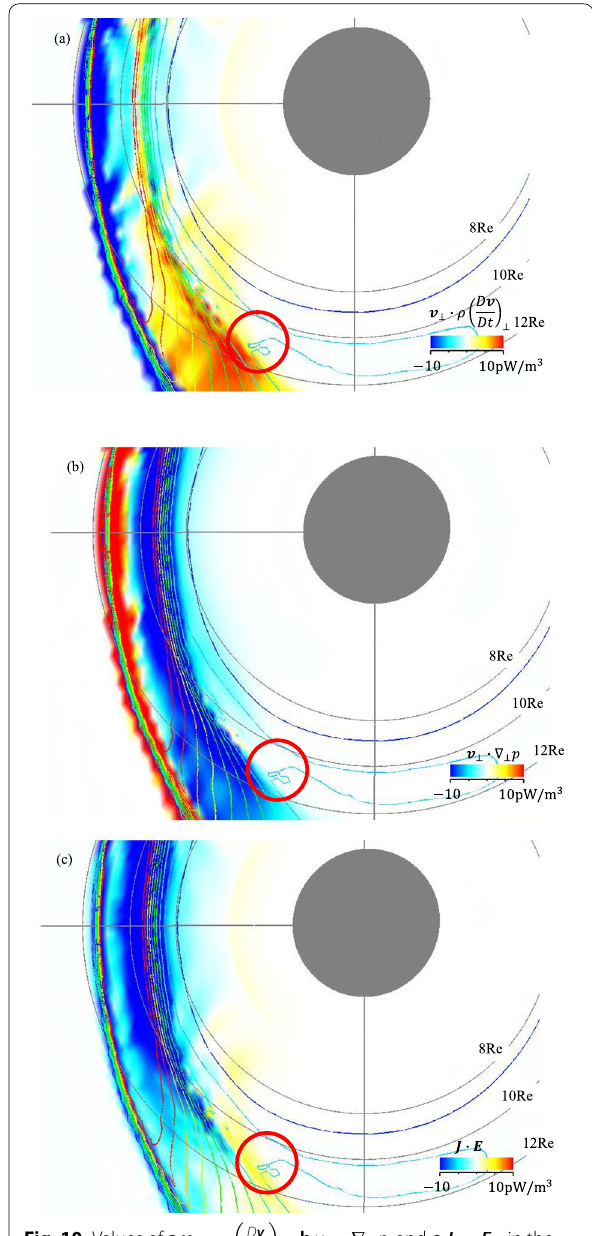
Fig. 10 Values of a v ⊥ · ρ (cid:31) D v Dt (cid:30) post-noon sector of the equatorial plane at t contours of each panel indicate equi-contour lines of the pressure. See Fig. 6 caption for the description of the red